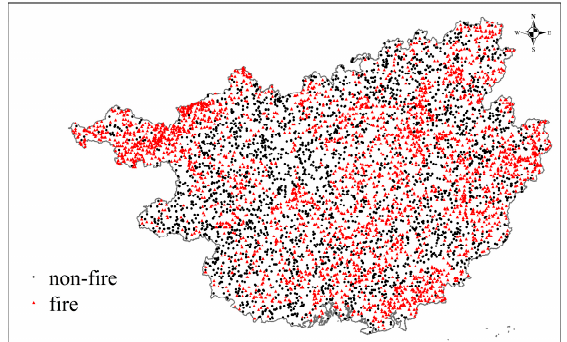
Figure 3. Samples of testing subset in the Guangxi province.